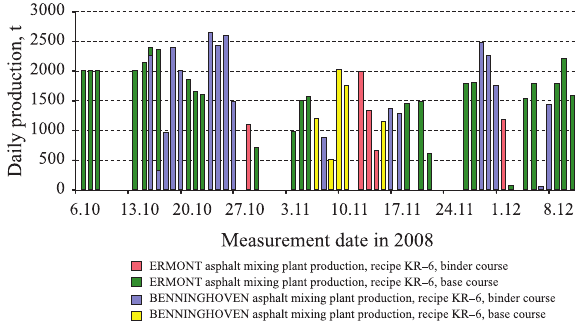
Fig. 6. Production capacity of the HMA